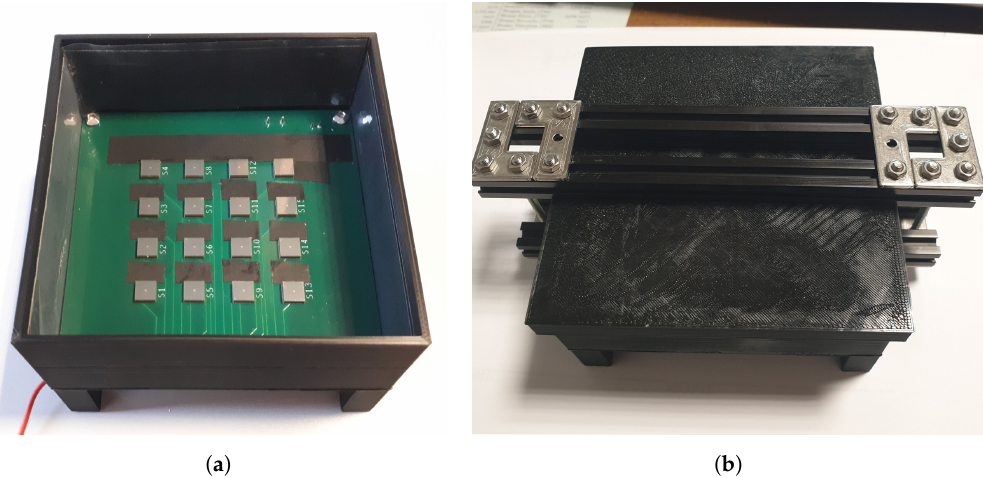
Figure 2. ( a ) View of the opened plastic box with the SiPM board on the bottom and filled with optical gel and ( b ) after the closure with the lid. Board size is 10 × 10cm 2 and the regular array of SiPMs, that are 1.5cm center-to-center equally spaced, is centered on the board. SiPMs have 6 × 6mm 2 nominal surface area.